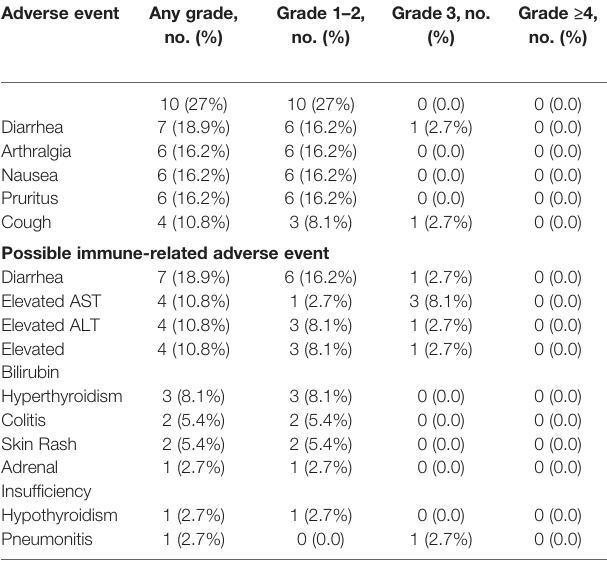
TABLE 2 | Treatment related adverse events occurring in ≥ 10% of patients and possible immune-related adverse events. Adverse